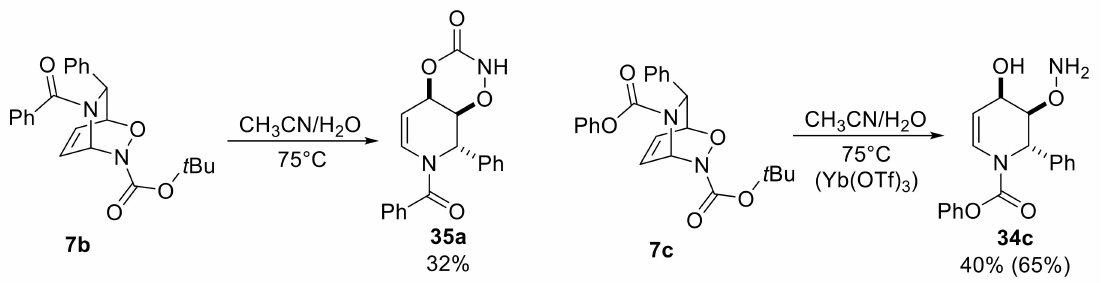
Scheme 17. Rearrangement of carbamate-NDA